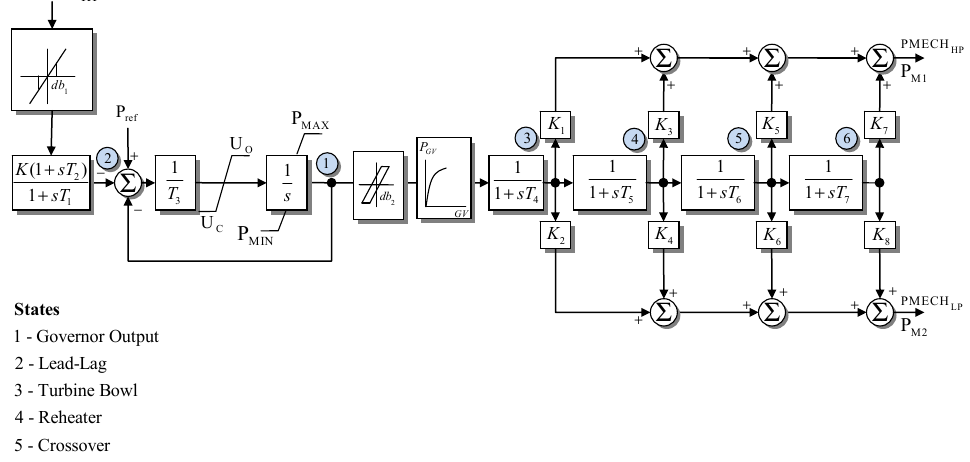
Figure 2. General steam turbine speed governing model of IEEE. (The parameters are defined in the literature [27])